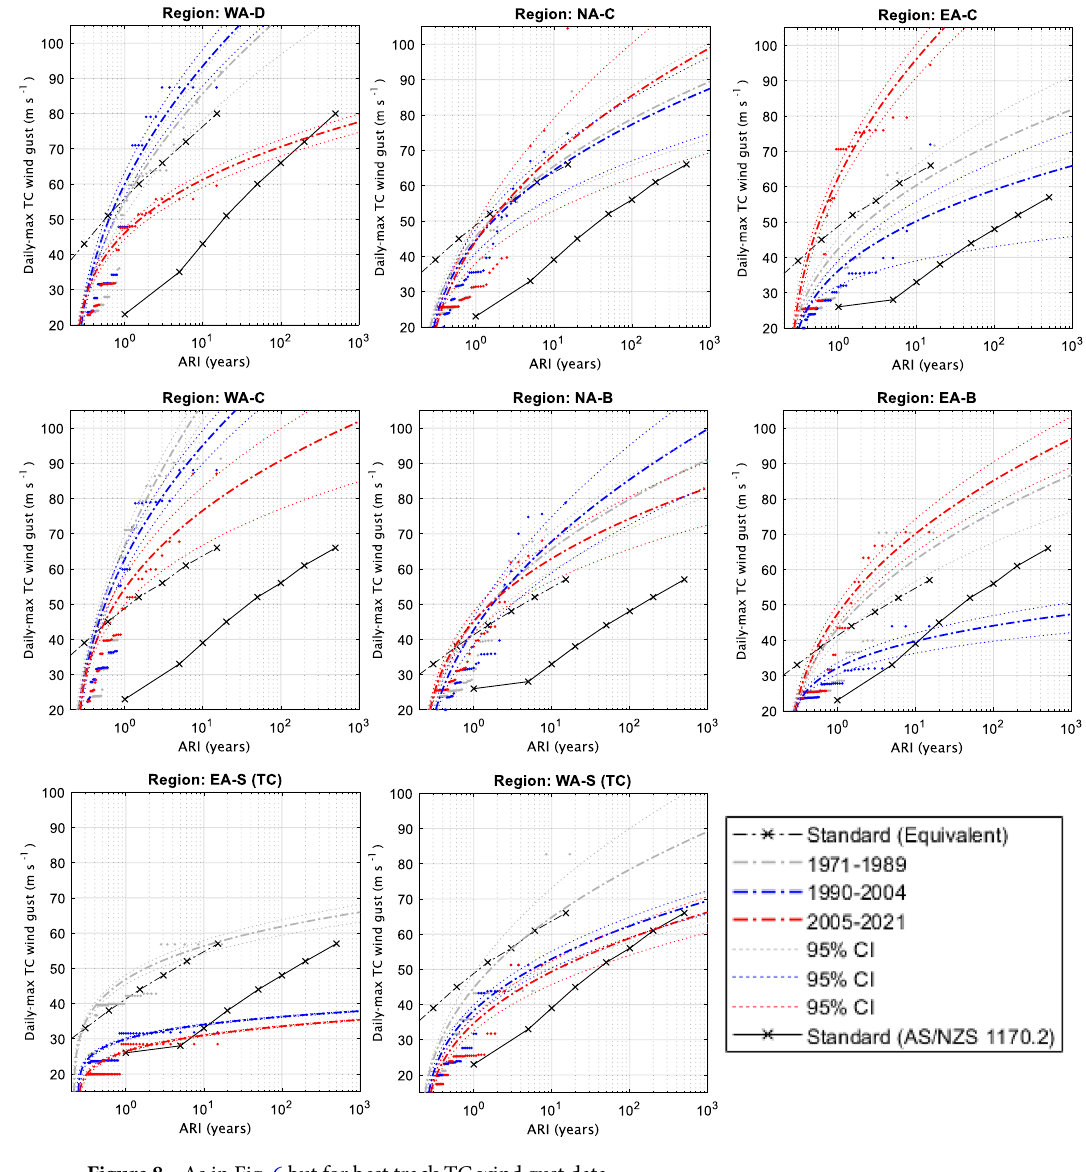
Figure 8. As in Fig. 6 but for best track TC wind gust